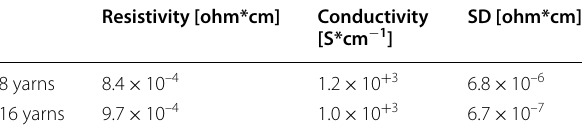
Table 2 Average value of the resistivity and conductivity for 8 and 16